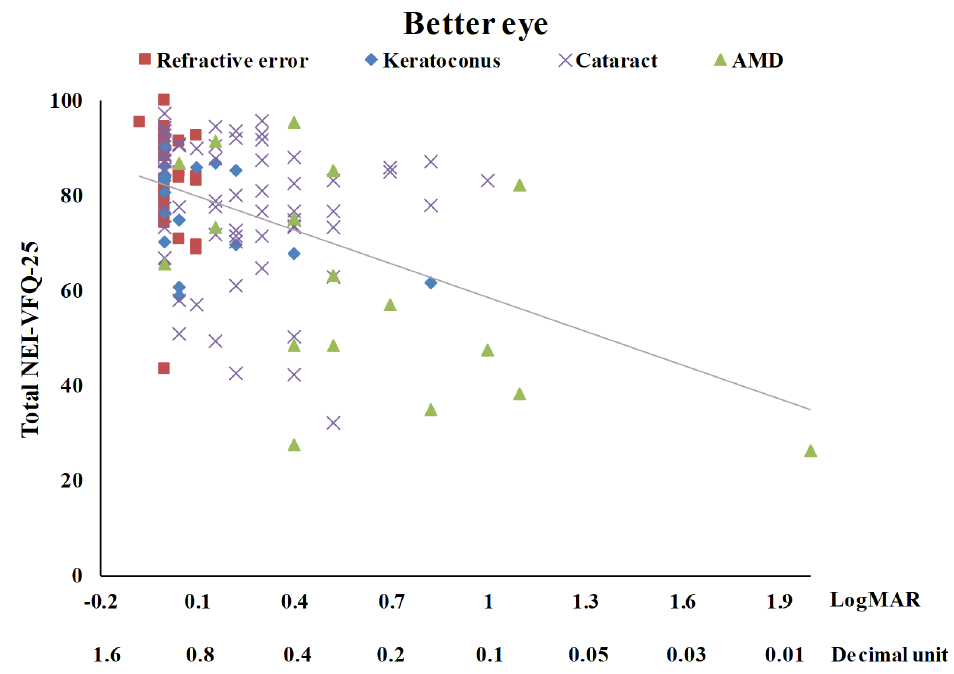
Figure 2. The scatter plot between total NEI-VFQ-25 score and the best-corrected visual acuity for the better eye (r = − 0.46, p < 0.0001).